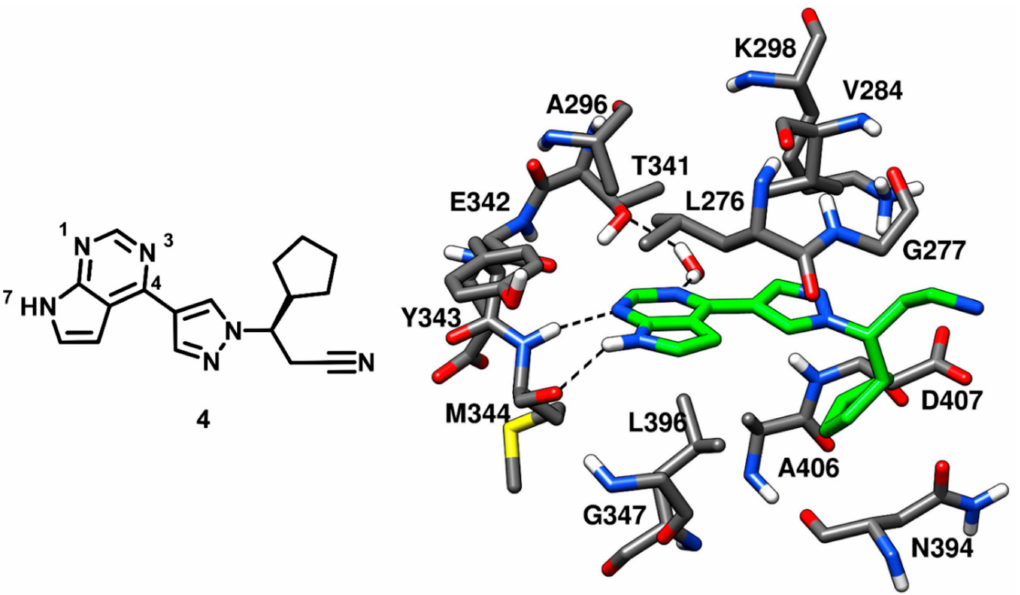
Figure 6. 2D structure of 4 and X-ray structure of c-Src kinase in complex with 4 (PDB ID: 4U5J). Active site residues of c-Src kinase and the enzyme–inhibitor H-bond interactions are